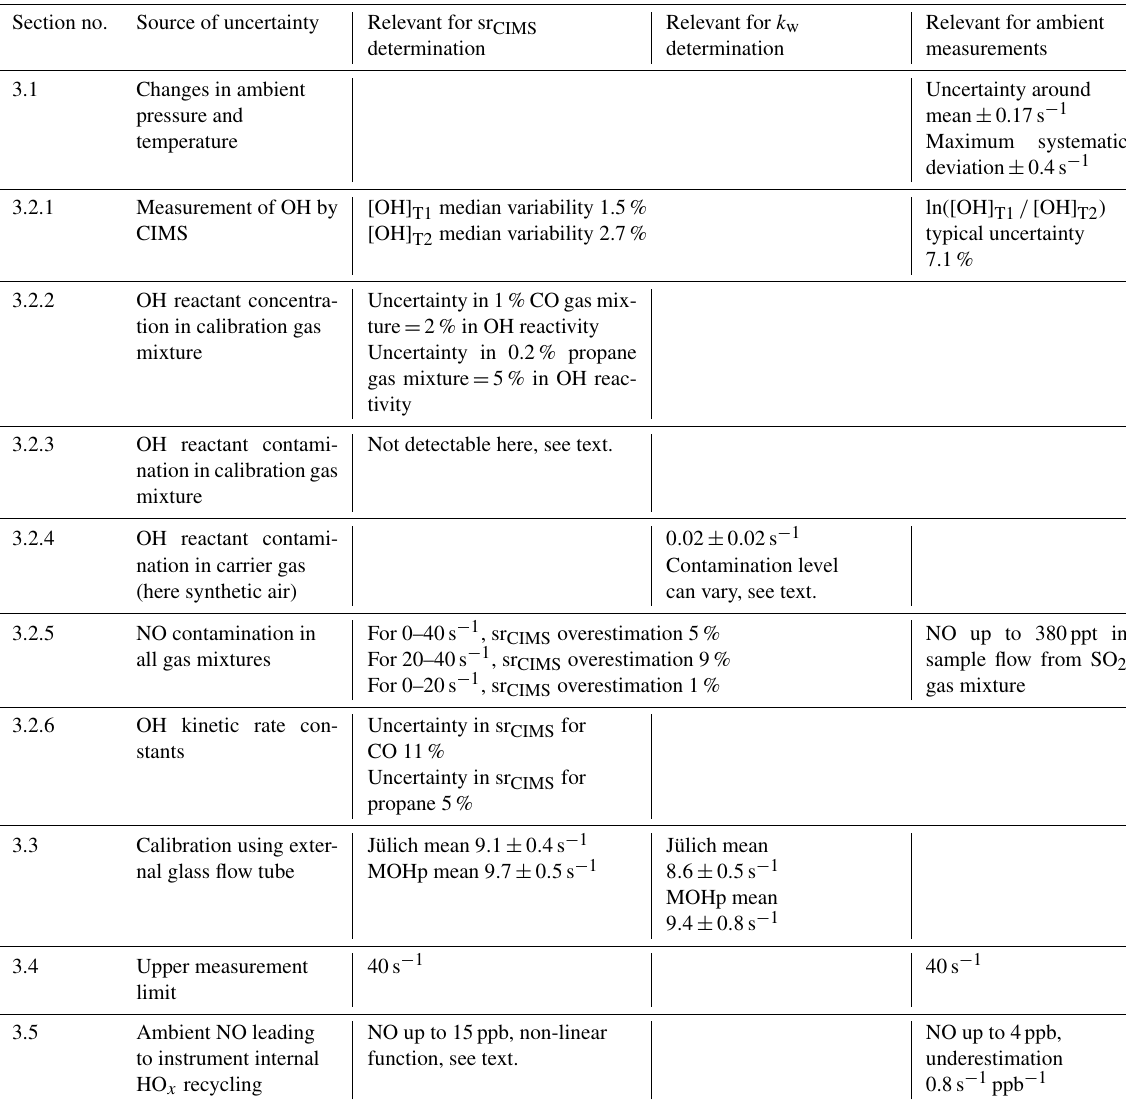
Table 2. Overview of uncertainties (1 σ ) and limitations discussed in Sect. 3, indicating relevance to scaling rate sr CIMS determination, wall loss rate k w determination and/or relevance for ambient measurements. Section